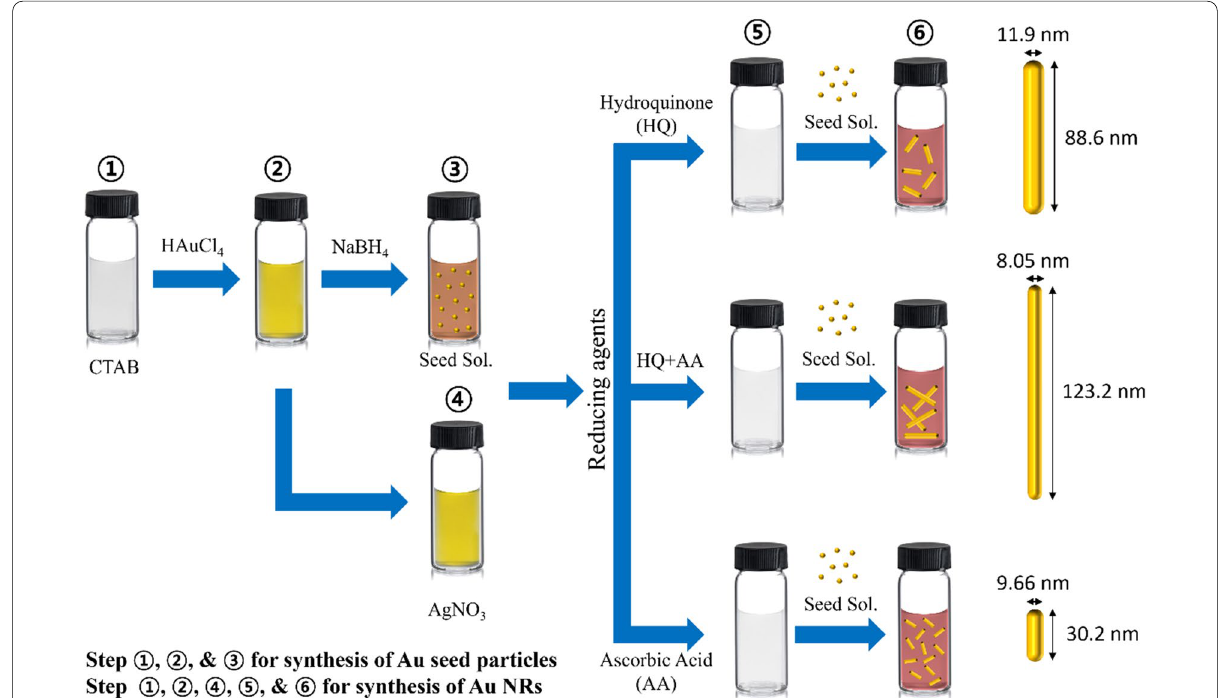
Fig. 1 Schematic of the synthesis of Au NRs via the seed-mediated